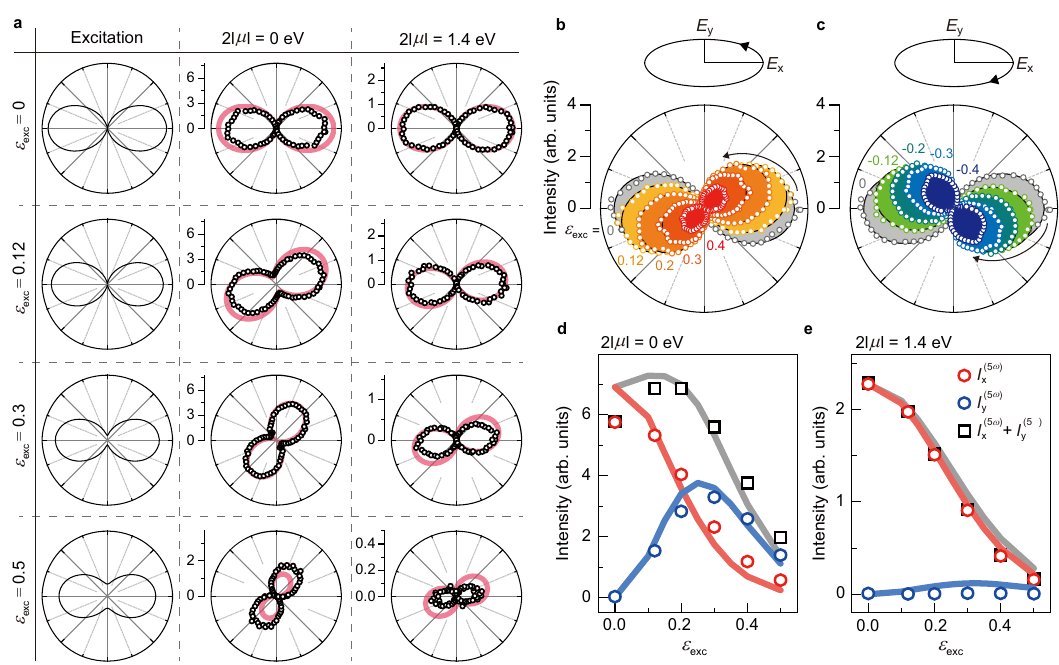
Fig. 3 | Polarization of the fi fth harmonics for the charge-neutral case and highlydopedcase.a Polarizationpro fi lesofthe fi fthharmonics.Blackcirclesshow the fi fth harmonic intensity measured after a linear polarizer as a function of polarizer angle φ . Polarization pro fi le of laser excitation with ellipticity ε exc = 0, 0.12,0.3,and 0.5 (leftcolumnlabeled withExcitation) is plotted asa guidance. For the charge-neutral case (middle column labeled with 2 ∣ μ ∣ = 0eV), the harmonic polarization sensitively rotates with ε exc . For the highly doped case (right column labeled with 2 ∣ μ ∣ = 1.4eV), the harmonic polarization nearly does not rotate up to ε exc =0.5. Pink solid lines show the theoretically calculated polarization, which